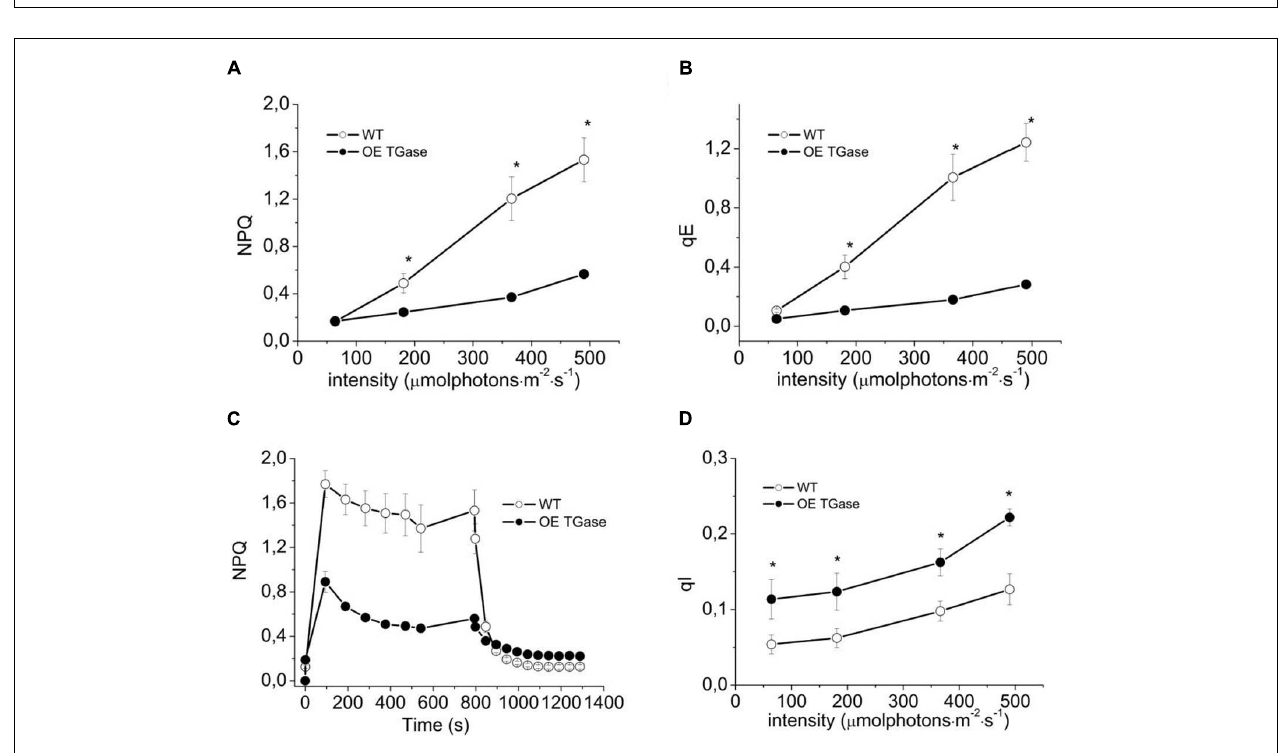
FIGURE 3 | Short term photoprotection mechanisms for intact WT (open symbols) and OE TGase (closed symbols). (A) Non-photochemical quenching in intact plants exposed to four different light intensities. There is lower NPQ for OE TGase, which is more evident at the higher intensity. (B) Energization quenching (qE) in intact plants exposed to four different light intensities. (C) Typical traces of NPQ induction and relaxation kinetics at 490 µ mol photons m − 2 s − 1 . (D) Photoinhibition quenching qI under the conditions of A,B . Error bars denote standard error ( n = 6) and asterisks statistically significant differences ( p <